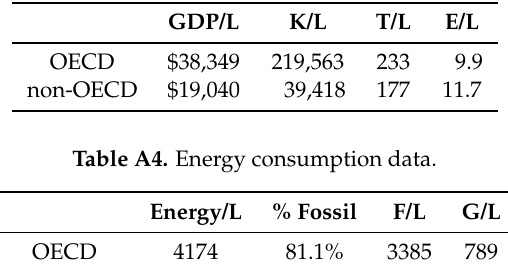
Table A3. Variable calibration.